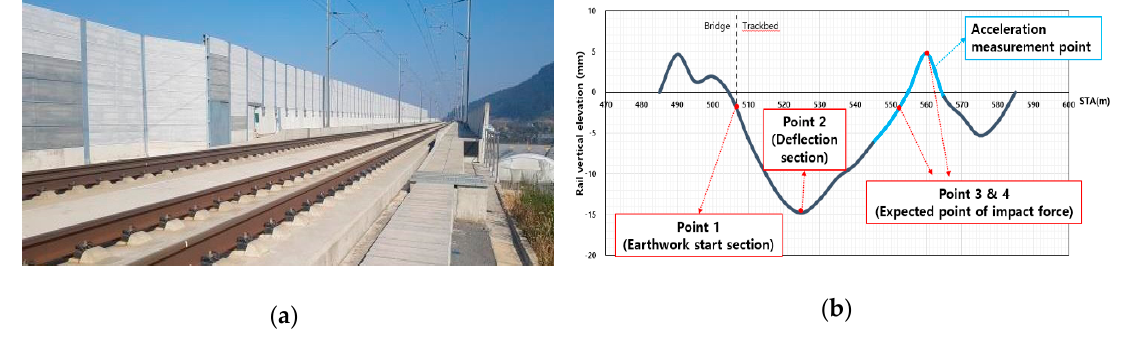
Figure 3. Measurement section. ( a ) Overview; ( b ) Profile of measurement section.